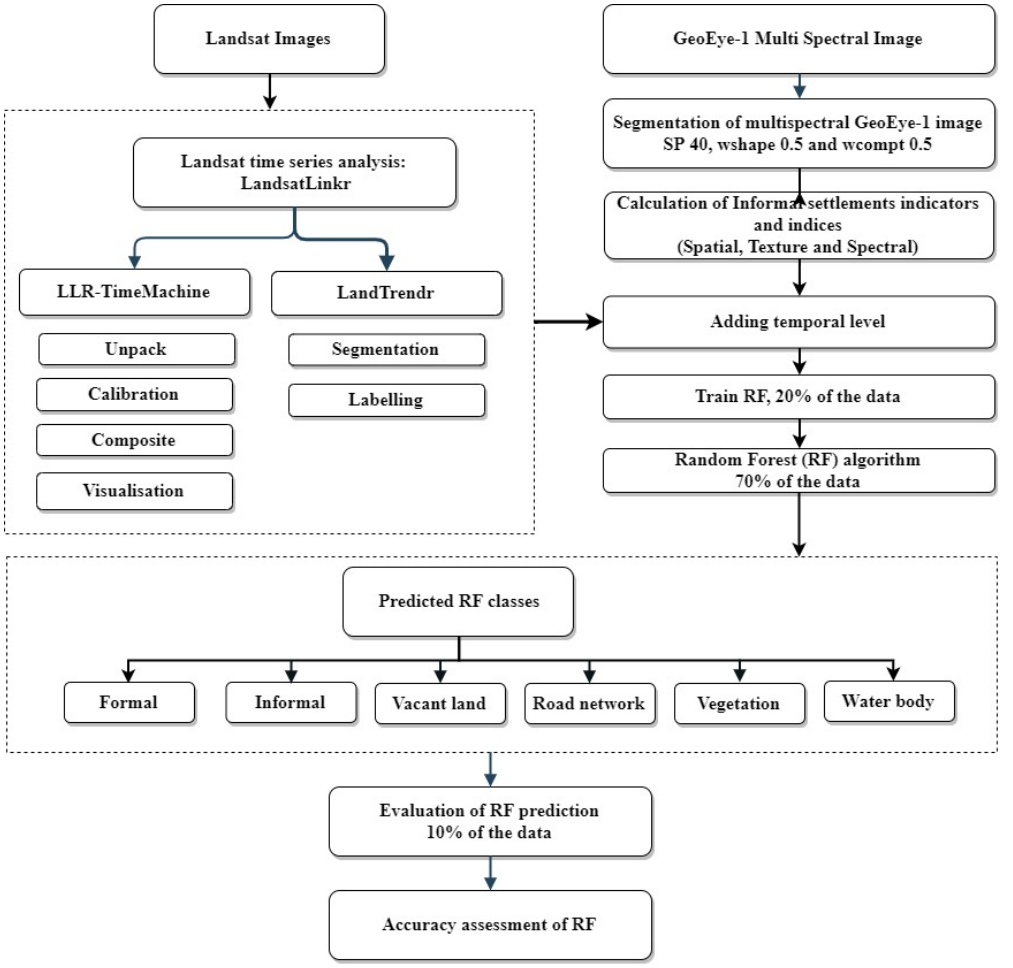
Figure 4. Flow chart for informal settlement identification in Jeddah using an object-based random forest approach that incorporates data from the LandsatLinkr.